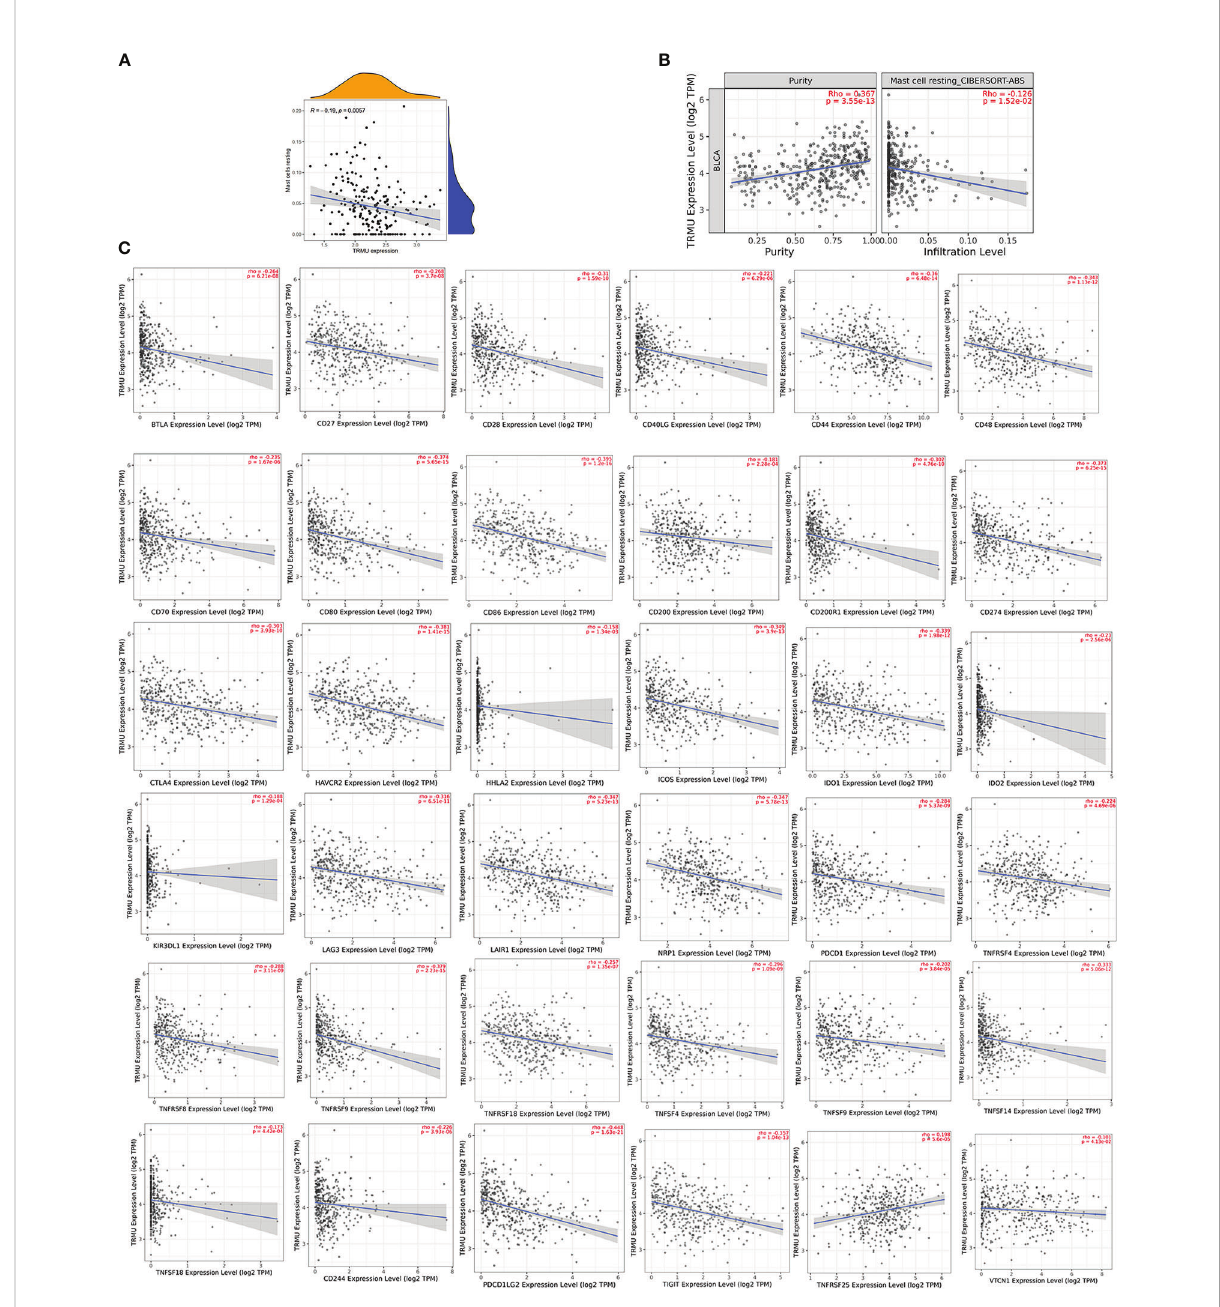
FIGURE 7 Correlation between TRMU and immune cells and immune checkpoint gene. (A) Relationship between TRMU and mast cell resting. (B) Correlation of TRMU and mast cell resting in TIMER database. (C) Correlation of TRMU and immune checkpoint gene in TIMER